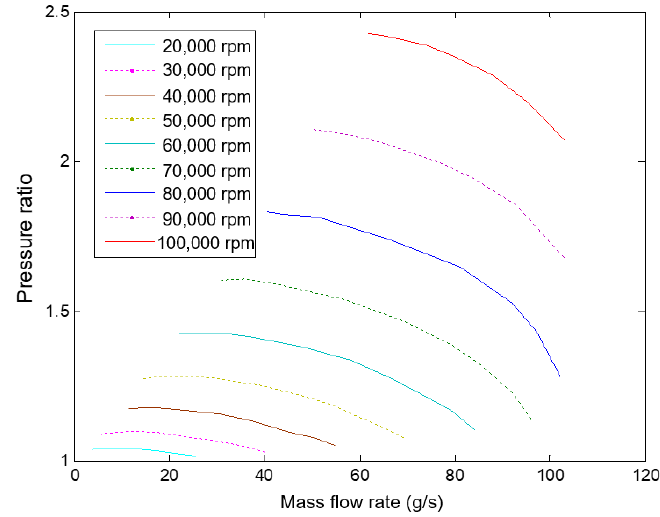
Figure 7. Flow–pressure ratio curve of the air compressor.